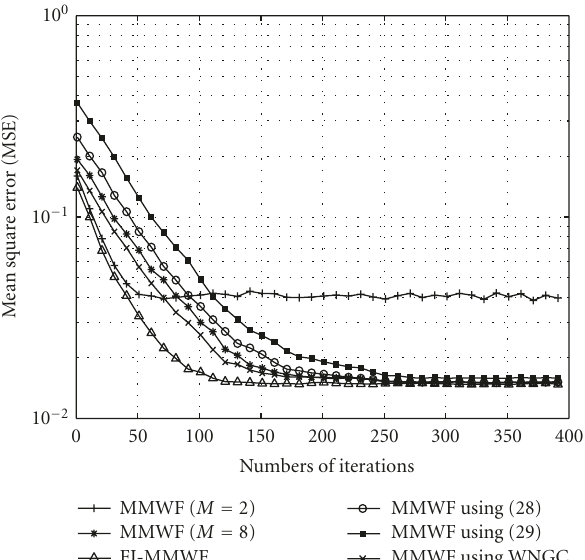
Figure 3: Mean square error versus the number of training symbols for reduced-rank MMWF-based algorithms.